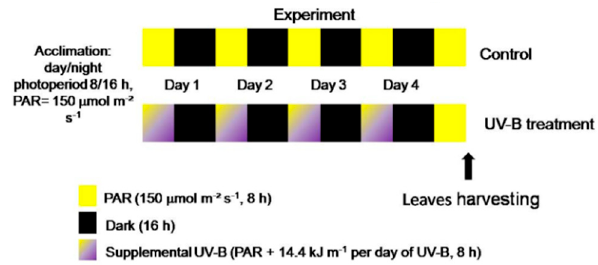
Figure 6. Scheme of the experimental light conditions.